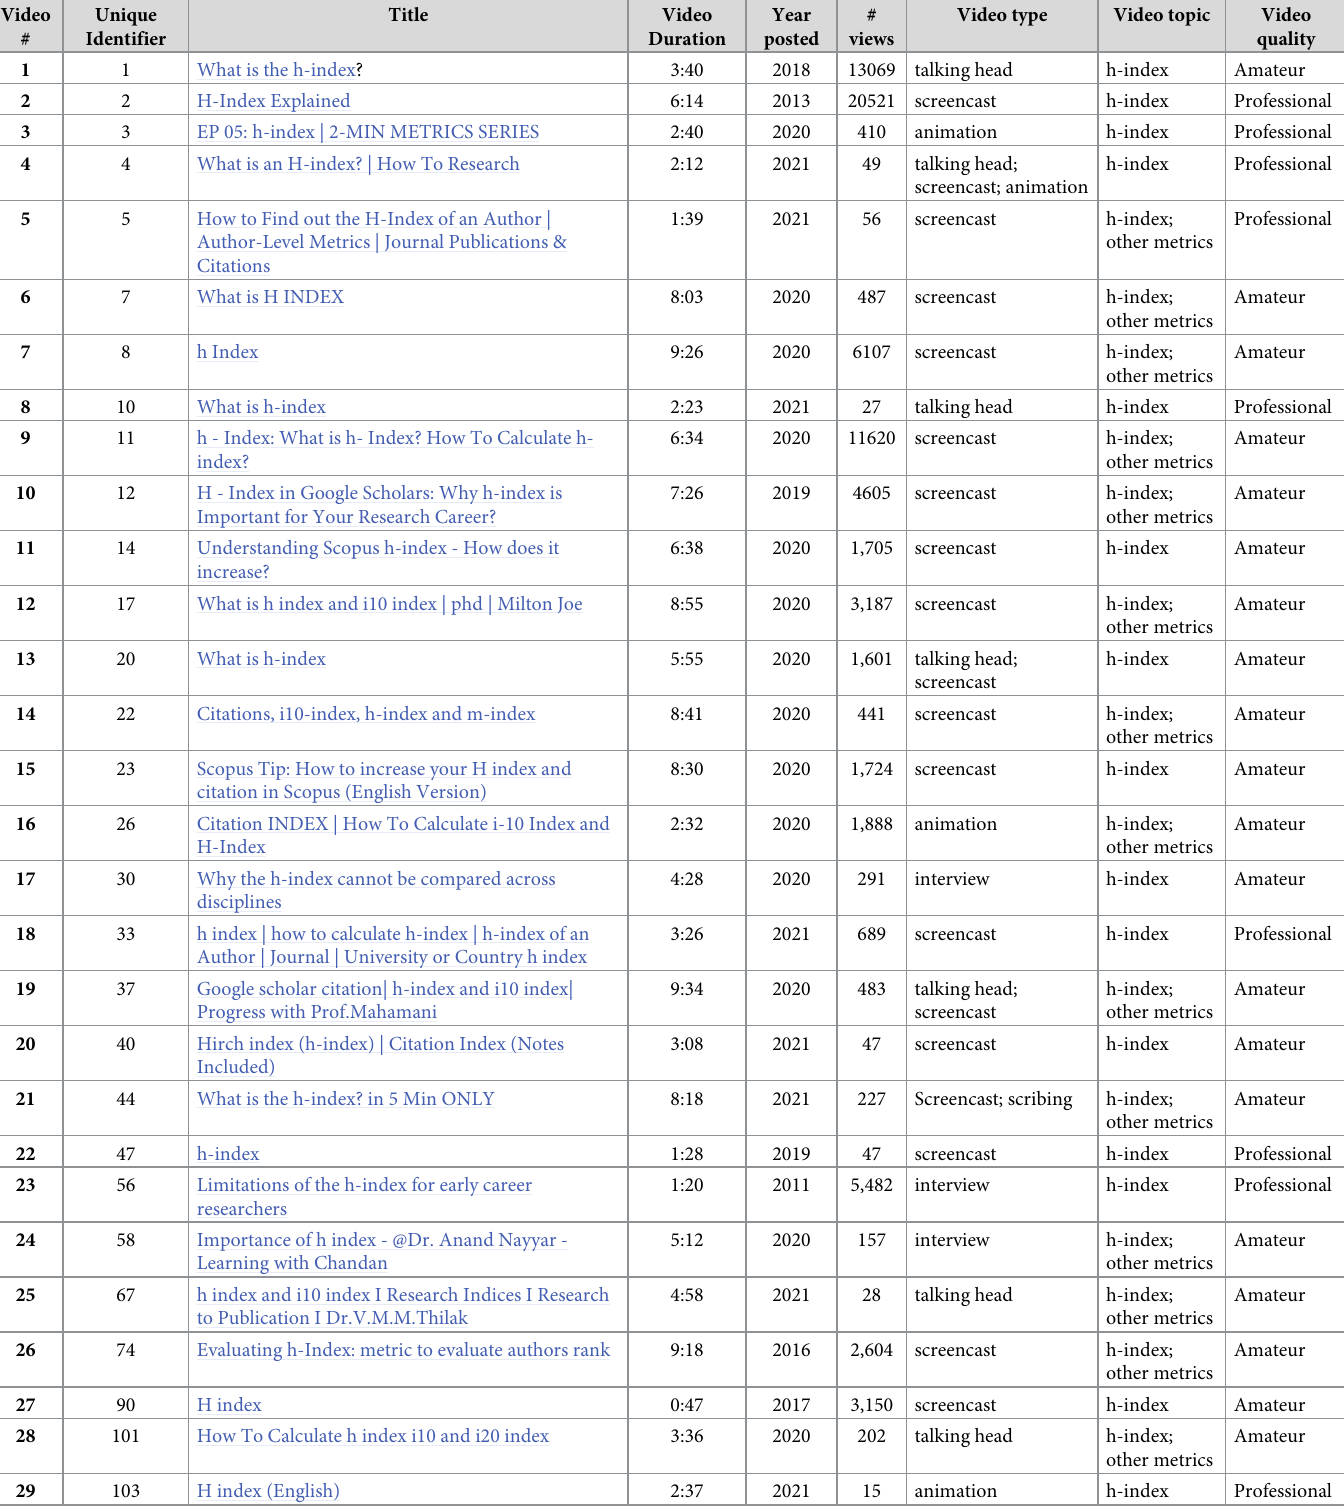
Table 1. Characteristics of YouTube videos on the h-index (n =